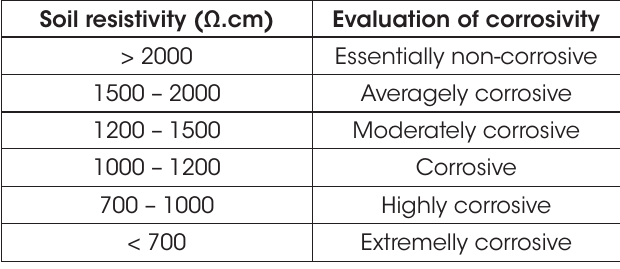
Classification of soil aggressiveness according